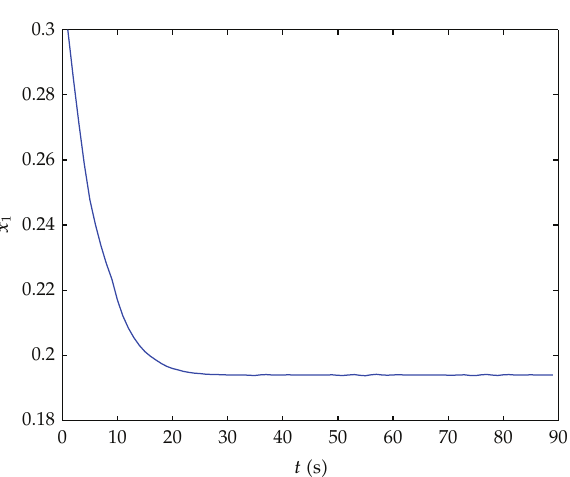
Figure 2: The trend of the prey numbers with T-S